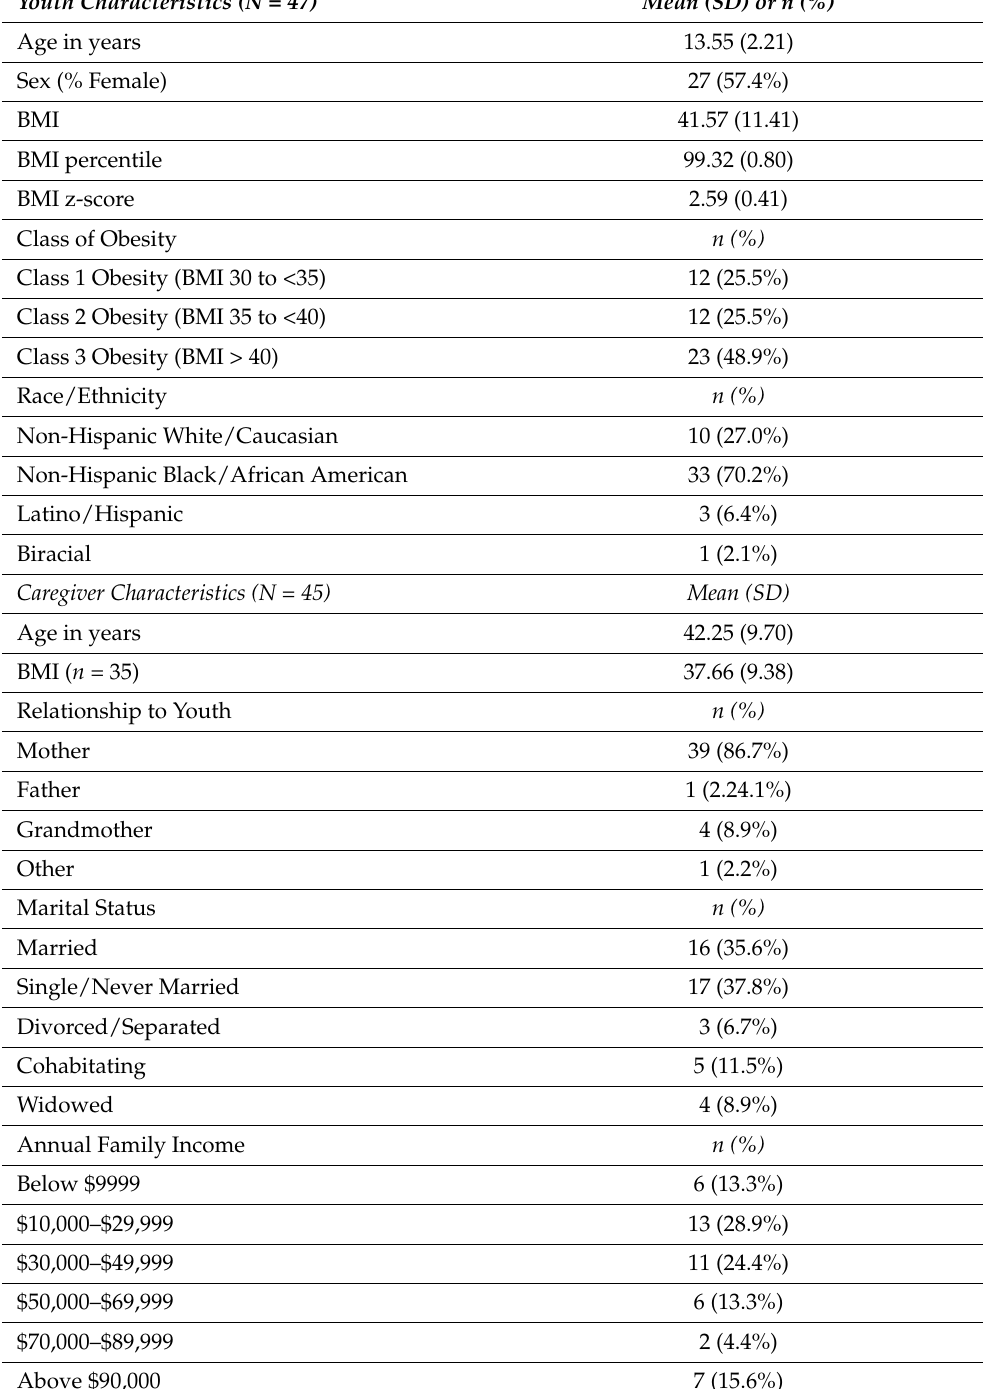
Table 1. Youth and Caregiver Demographic